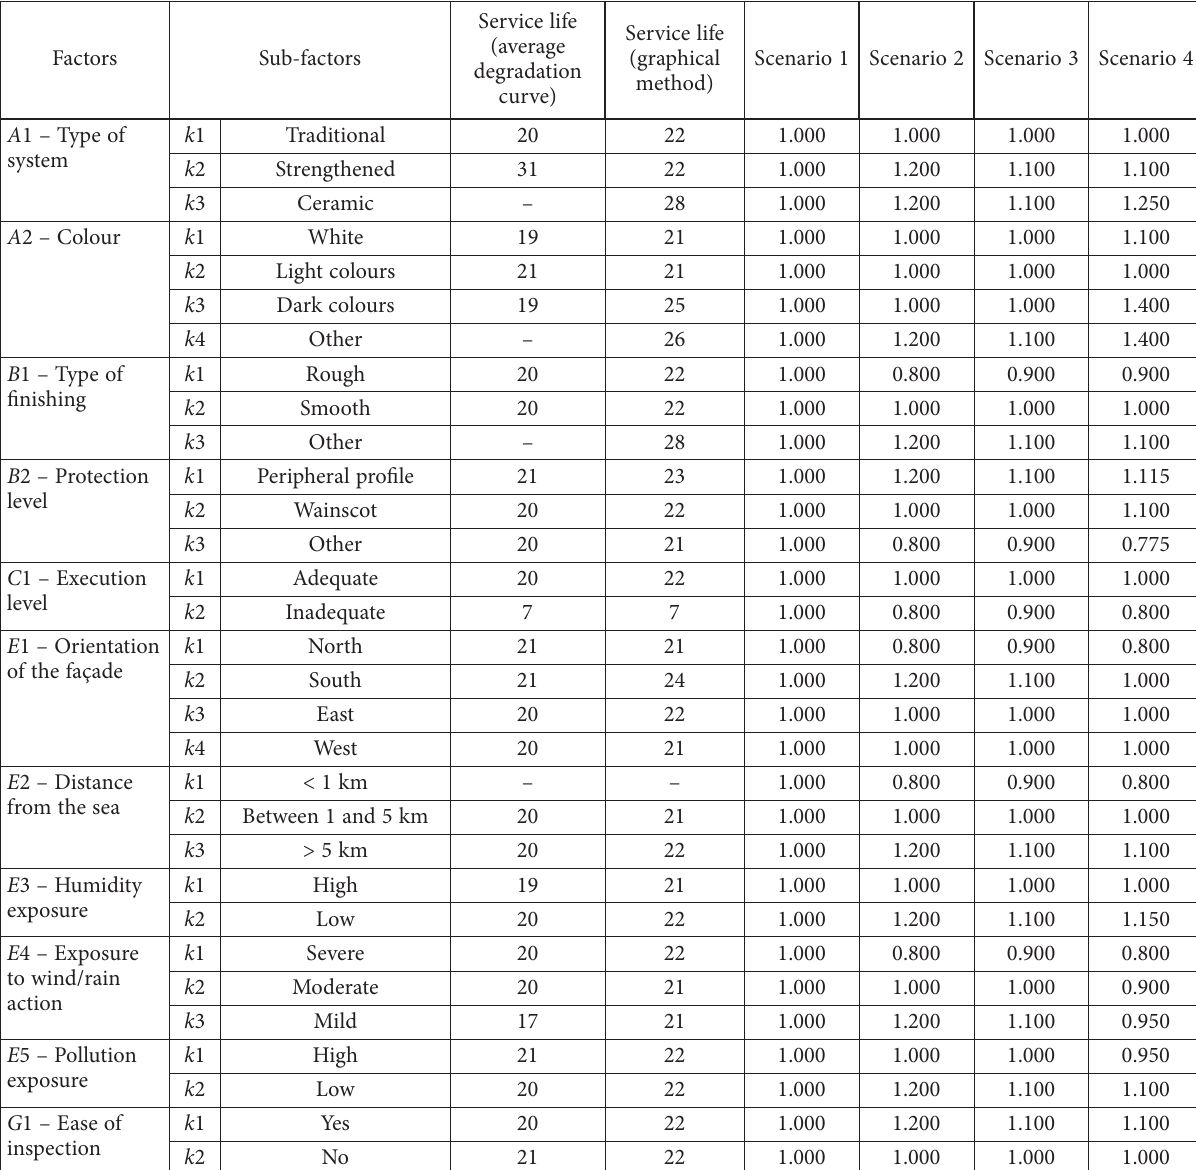
Table 2. Quantification of the durability sub-factors for the scenarios